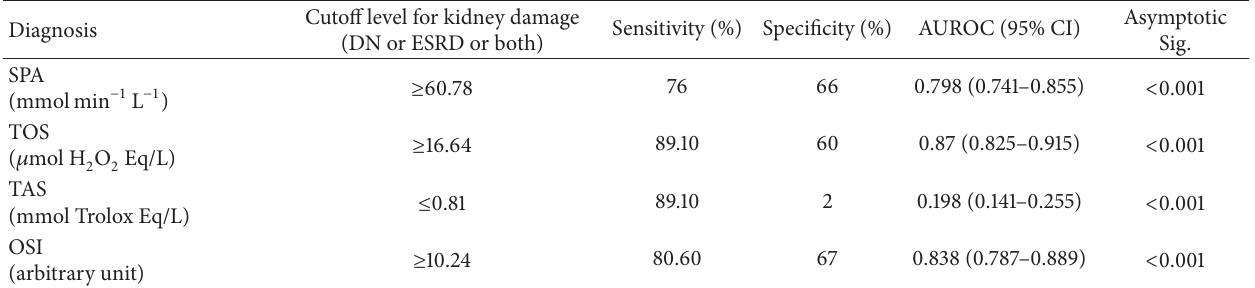
Table 5: Values of SPA, TOS, TAS, and OSI sensitivity and specificity for prediction of kidney damage (including both values of case-1 and case-2) with respect to control-1 and